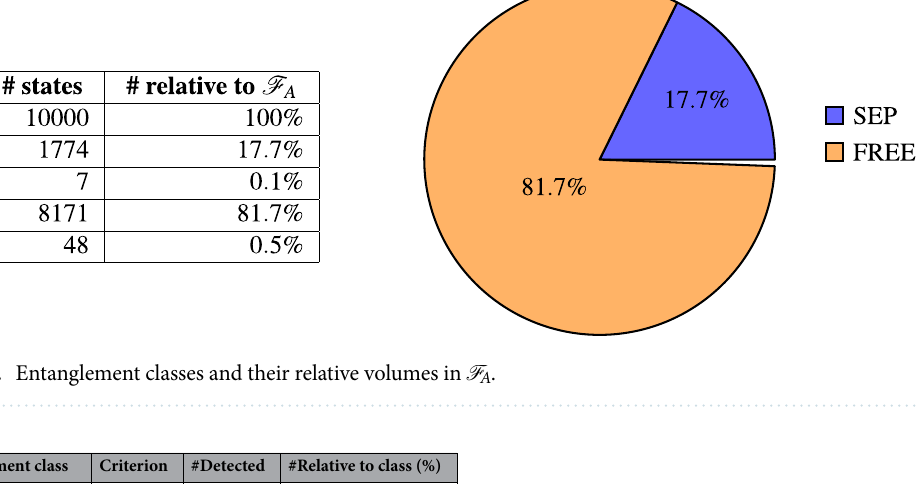
Entanglement class